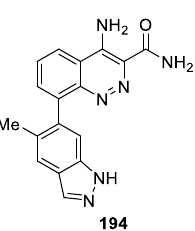
Figure 67. Chemical structure of 1 H -indazole derivative 194.